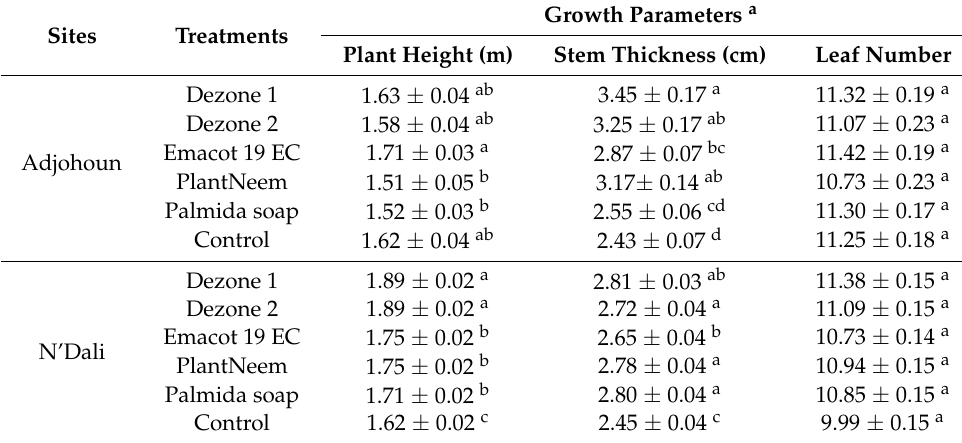
a Means within columns followed by different letters are significantly different, SNK multiple comparison test ( p ≤ 0.05). Dezone 1 and 2 refer to application rates of 7.5 and 15 kg/ha, respectively. 3.2.6. Yields and Percentage Reduction in Grain Yield Loss Cob and grain yields were significantly affected by treatments (cob: F = 10.93, df = 5, 81, p < 0.001; grain: F = 10.87, df = 5, 81, p < 0.001) and sites (cob: F = 58.51, df = 1, 81, p < 0.001; grain: F = 78.22, df = 1, 81, p < 0.001) (File S8). The yields obtained at N’Dali were 16 to 123% higher than those of Adjohoun. In general, yields were significantly higher in plots treated with an insecticide compared to control plots. The highest average maize yields were obtained in the two Dezone treatments and Emacot 19 EC at N’Dali, but the grain yield obtained with Dezone 1 was 10% higher than that of the positive control Emacot 19 EC. In Adjohoun, the two Dezone treatments promoted higher yields compared to other biopesticides, while the highest yields of all treatments were obtained with Emacot 19 EC. All insecticides substantially reduced yield losses with the percentage reduction in grain yield loss varying between 20 and 60% across treatments and sites (Table 5). Table 5. Maize cob and grain yields and yield loss reduction percentages under insecticide applications in the field. Yield (kg · ha − 1 ) a Percentage Reduction in the Grain Yield Loss Sites Treatments (%)Maize Cob Maize Grain Negative Control Adjohoun